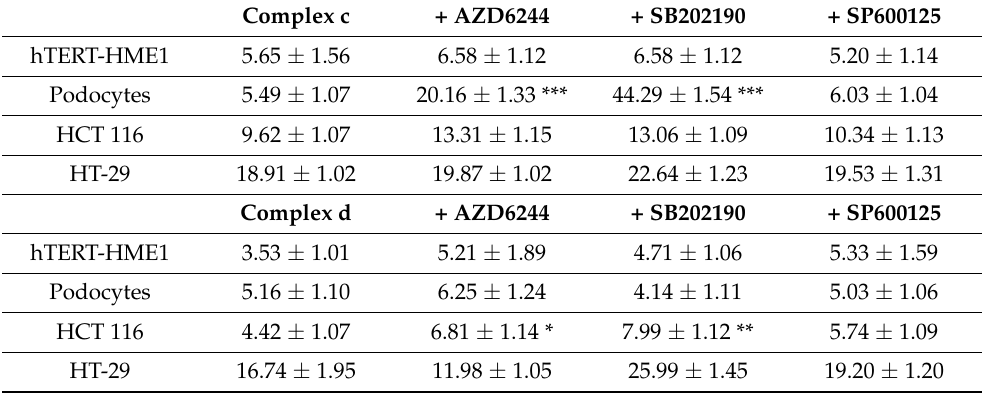
Table 1. IC 50 values of antiproliferative effect of complex c and complex d. IC 50 was calculated in all cell lines in the presence or not of MAPKs inhibitors. Cells were pre-treated with AZD6244, SB202190, or SP600125 (all 100 nM), inhibitors of p42/44, p38, and JNK, respectively, for 30 min; then cells were treated with complexes (50–0.206 µ M) for 6 days. Values are expressed as mean ± S.E.M. of at least four independent experiments. * p < 0.05; ** p < 0.01; *** p < 0.001: complex + MAPK inhibitor vs.